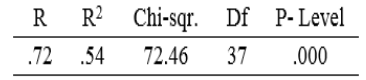
Table 3. Canonical Correlation Analysis of functional abilities and success in motor agility